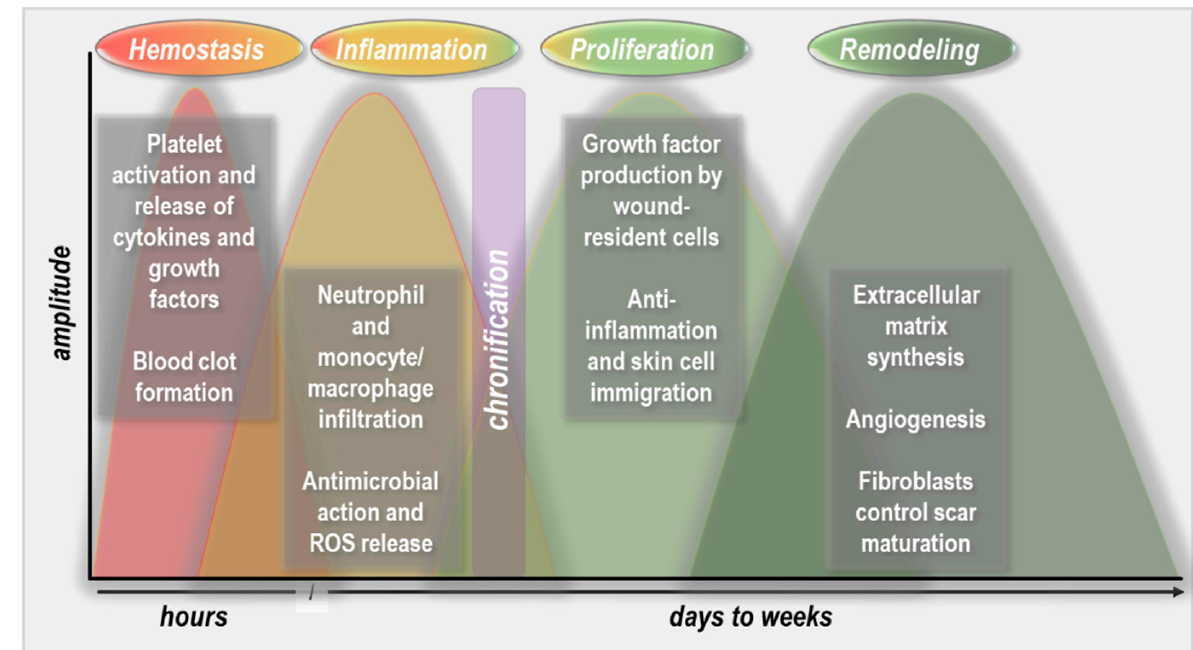
Figure 1. Wound healing stages. During hemostasis, platelets become activated to contribute to blood clot formation and release cytokines and growth factors. This is followed by the inflammation phase, which is characterized by extensive immigration of phagocytes, predominantly neutrophils and macrophages, to promote inflammation and pathogen clearance. During the subsequent proliferation phase, profound anti-inflammatory and growth-promoting processes are induced that allow the immigration of fibroblasts and keratinocytes into the wound bed, guided by growth factor production and gradients. Once the wound is closed, the final step is the remodeling of the skin architecture, which is mainly driven by fibroblasts and extracellular matrix synthesis and accompanied by angiogenesis to restore near-original tissue strength.